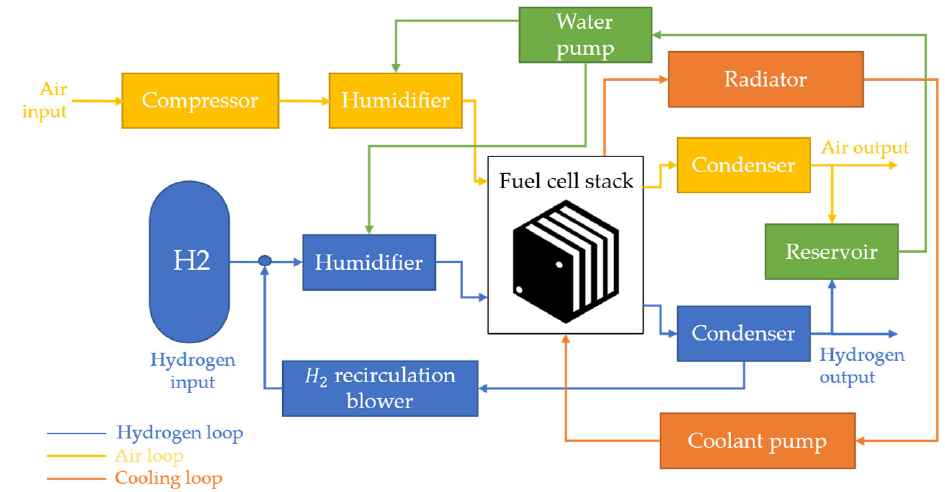
Figure 3. Schematic of the retained fuel cell system model.